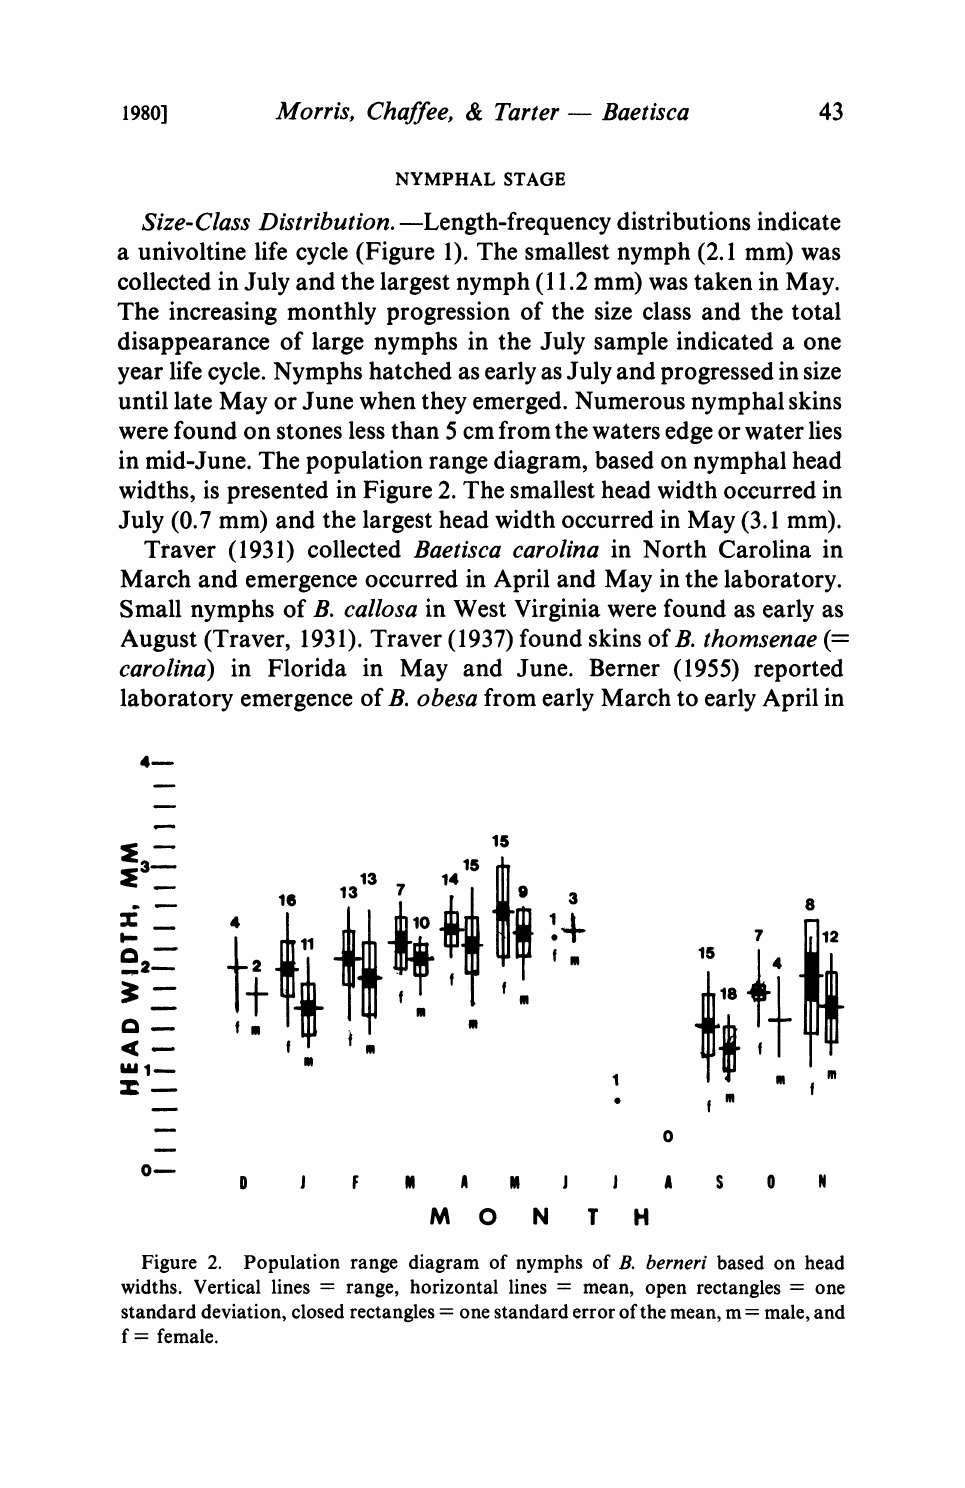
Figure 2. Population range diagram of nymphs of B. berneri based on head widths. Vertical lines range, horizontal lines mean, open rectangles one standard deviation, closed rectangles one standard error of the mean, m male, and f